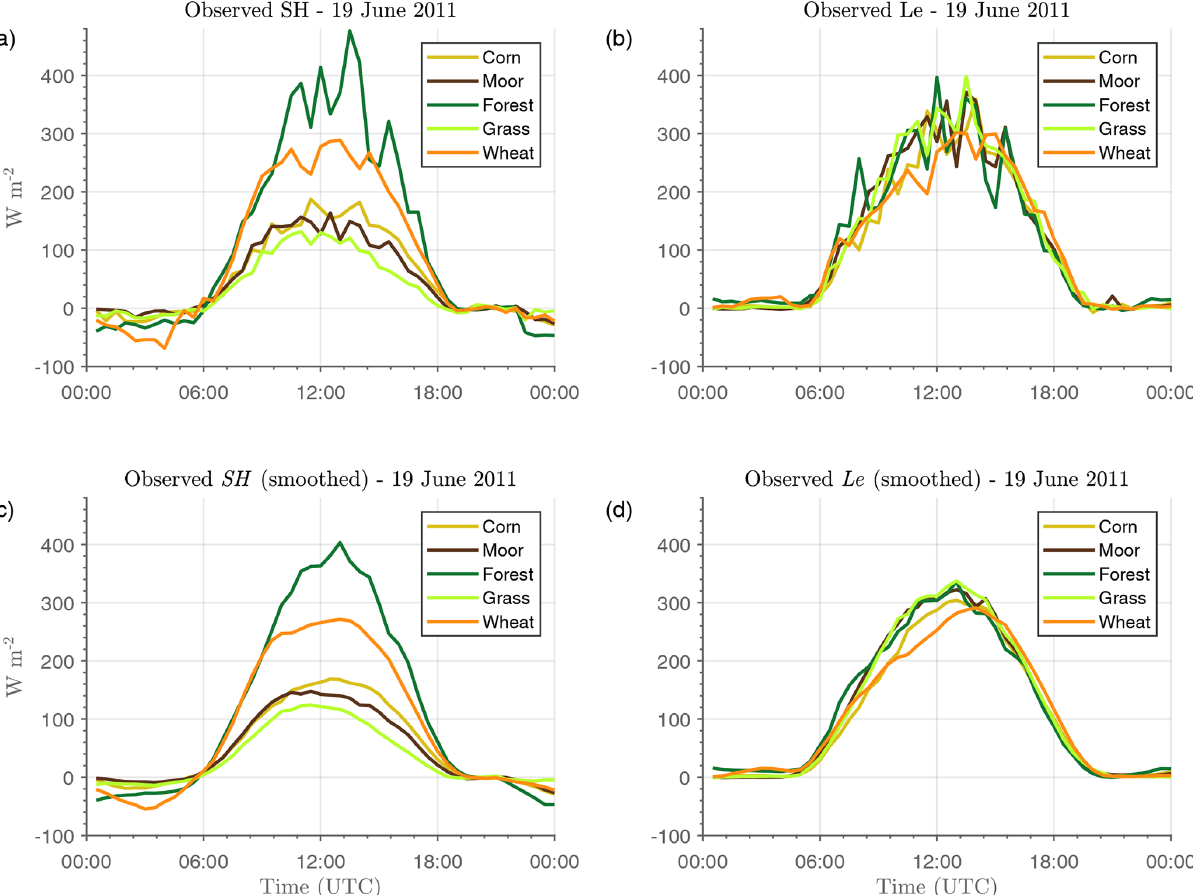
Figure 1. (a) Observed sensible heat flux (SH) on 19 June 2011 during the BLLAST campaign over different vegetation types. (b) The same for the latent heat flux (Le). (c, d) Same as in (a) and (b) , but with the time series smoothed for a better visualization of the main differences between vegetation types. The flux values were calculated using the eddy-covariance technique with averaging windows of